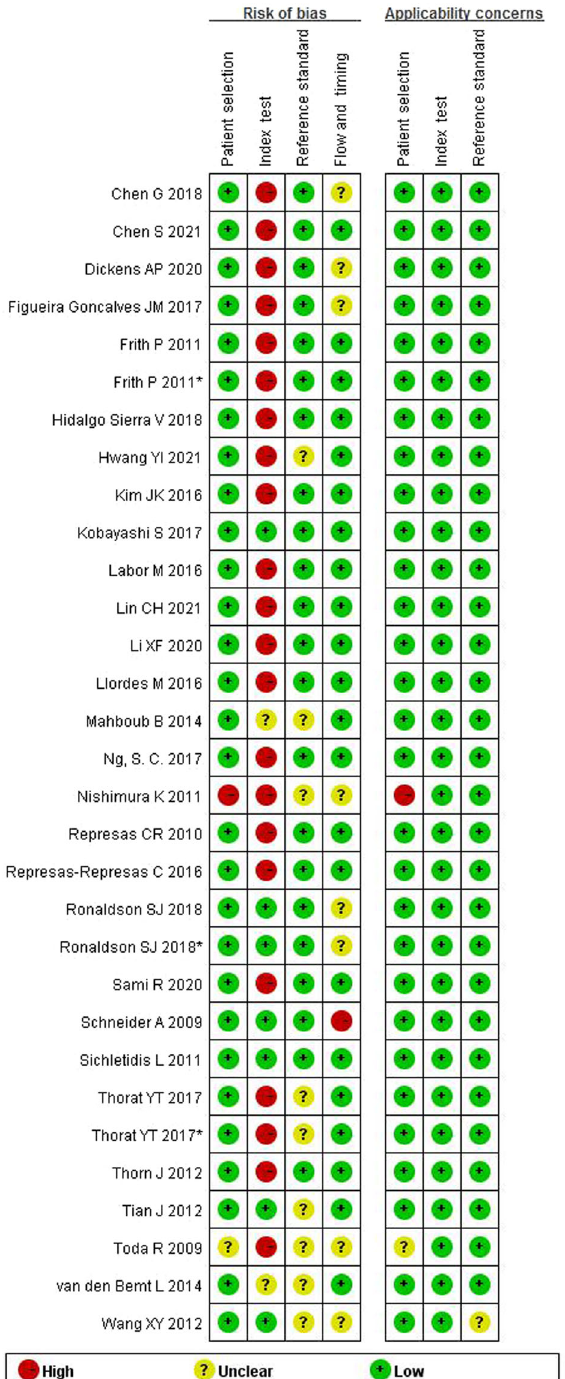
Fig. 2 Summary map of risk of bias across domains of the included studied. Using QUADAS-2 tool. Key domains: patient selection; index test; reference standard; study fl ow and timing. The risk of bias is indicated by three colors, red for high risk of bias, yellow for unclear risk of bias, and green for low risk of bias.